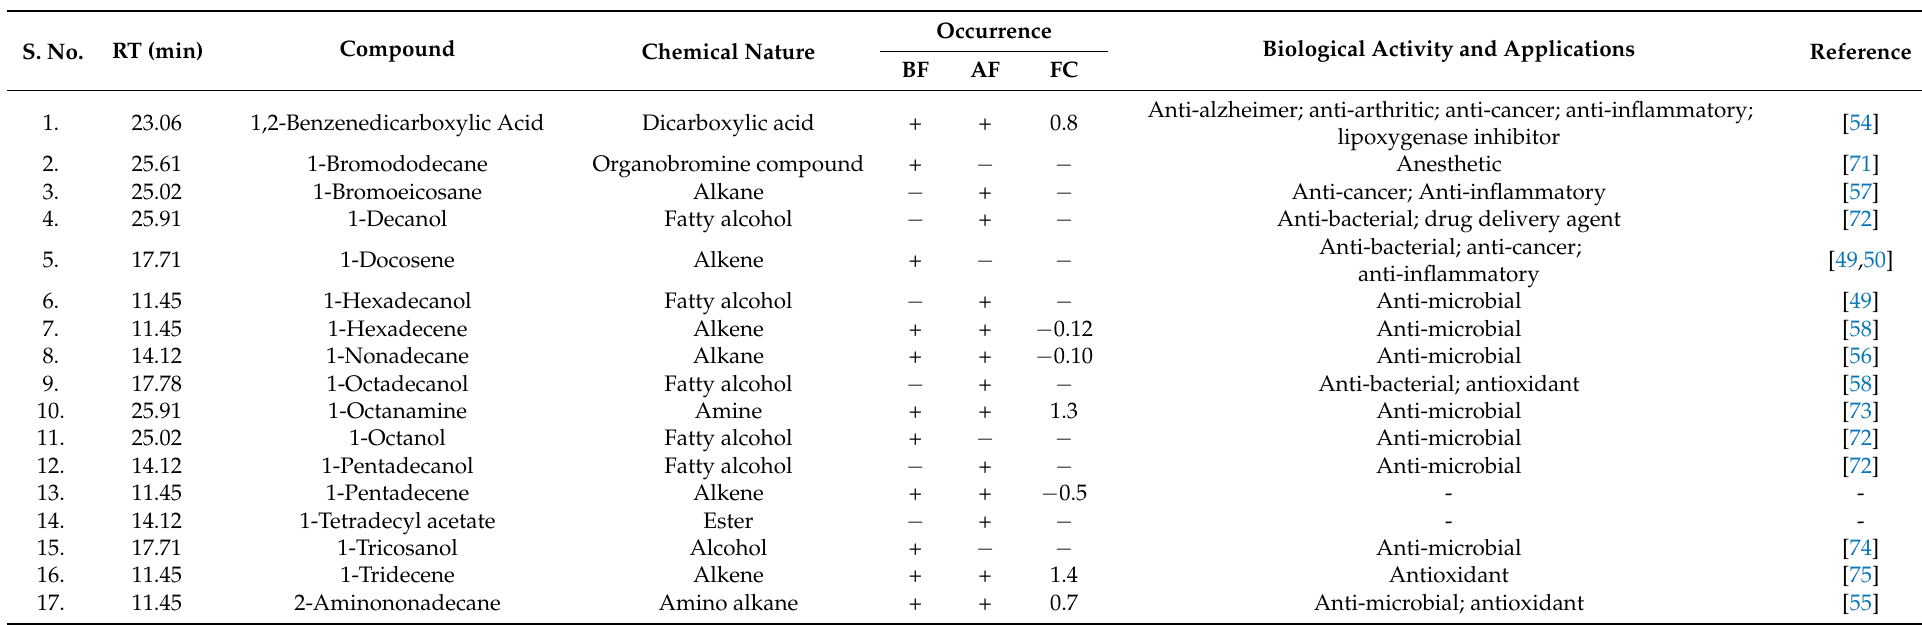
Table 3. GC-MS basedmetabolomic fingerprint data of the functional soymilk (manually integrated with previously reported biological